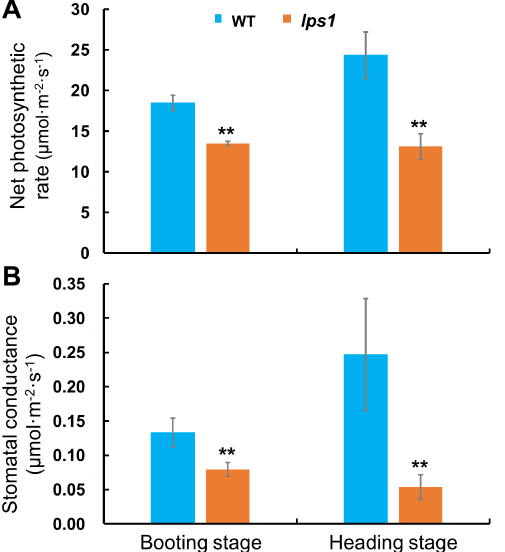
Figure 5. Photosynthetic capacity of top one leaf or flag leaf of WT and lps1 at booting stage and heading stage. ( A ) Net photosynthetic rate ( P n ). ( B ) Stomatal conductance ( G s ). Error bars represent standard deviations of three independent biological replicates. The statistically significant differences were performed by Student’s t test. ** p <